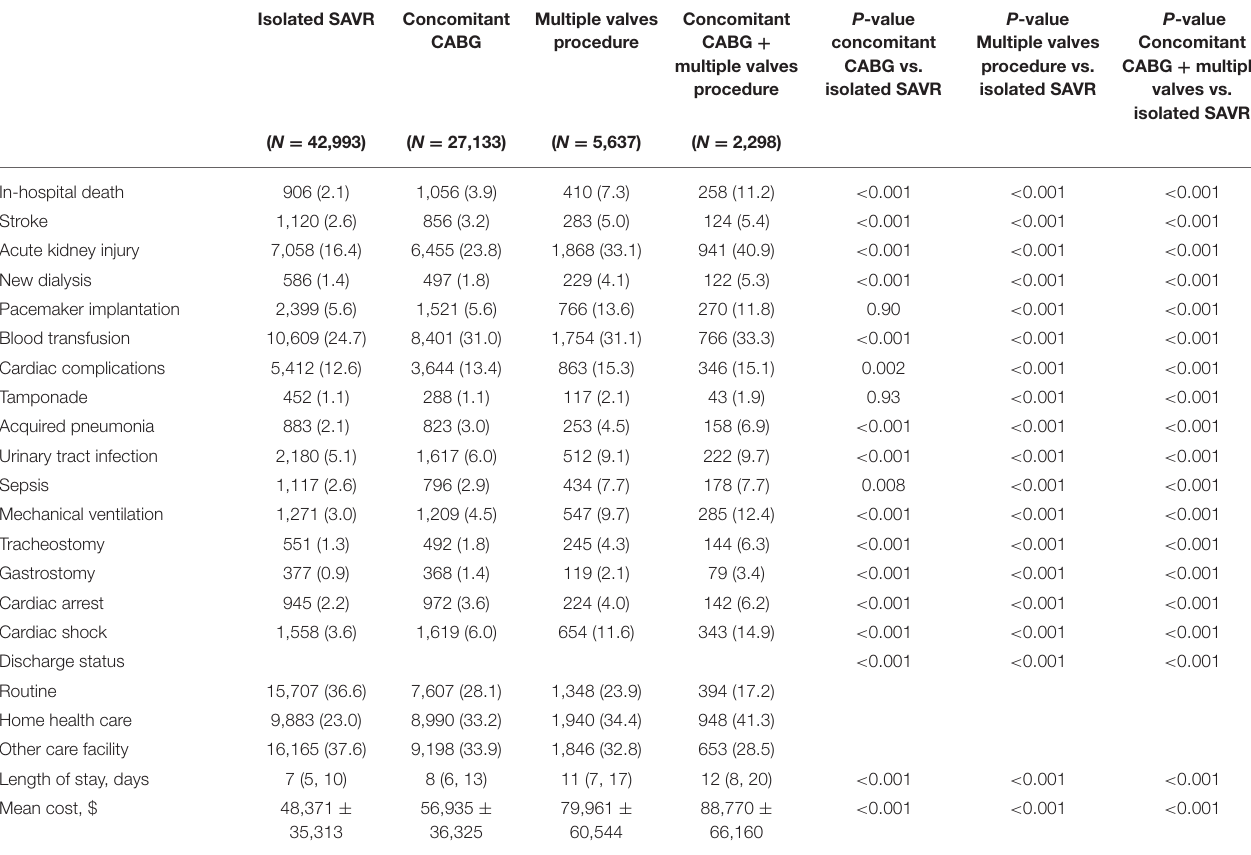
TABLE 2 | In hospital outcomes of SAVR with or without concomitant CABG and/or multiple valves procedure in the unmatched cohorts.